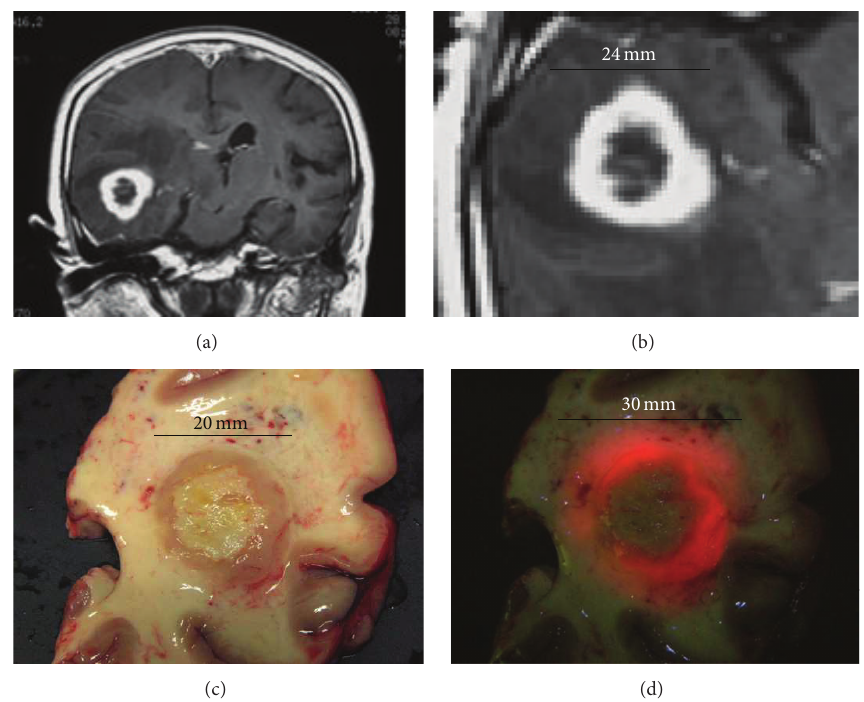
Figure 6: The size of the tumor using different methods. (a) MRI image shows the glioblastoma in the right temporal lobe. (b) It was 24 mm on enhanced MRI. (c) It was 20 mm on macroscopic observation under the white light. (d) It was 30 mm on macroscopic observation and fluorescence to the naked